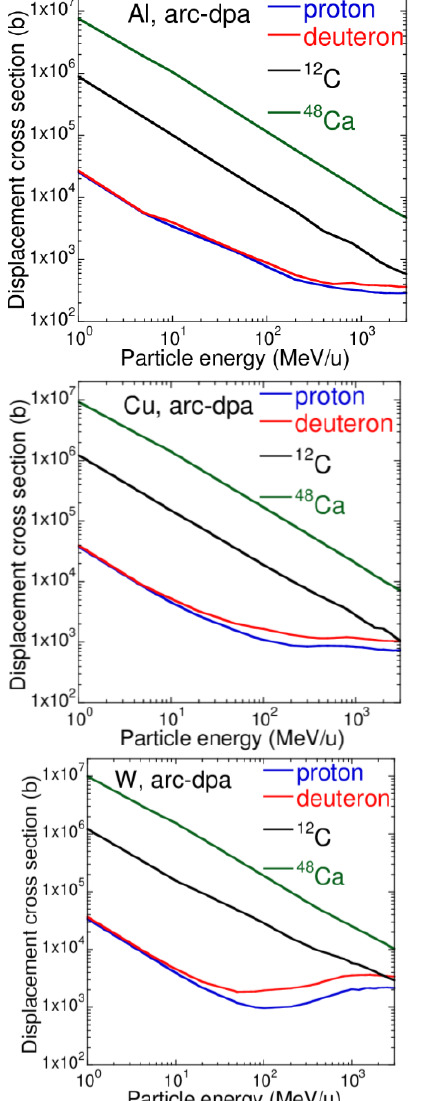
Figure 4 . arc-dpa cross sections for proton, deuteron, 12 C and 48 Ca irradiations